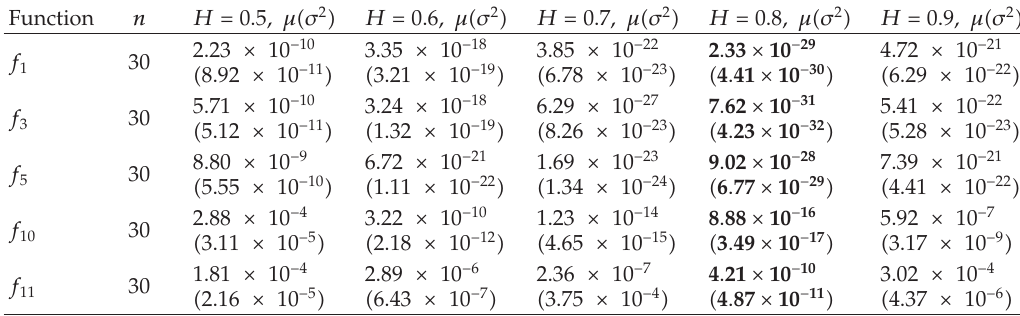
Table 2: Results of CAB with variant values of parameter H over 5 typical functions, with P (cid:8) 0 . 8.